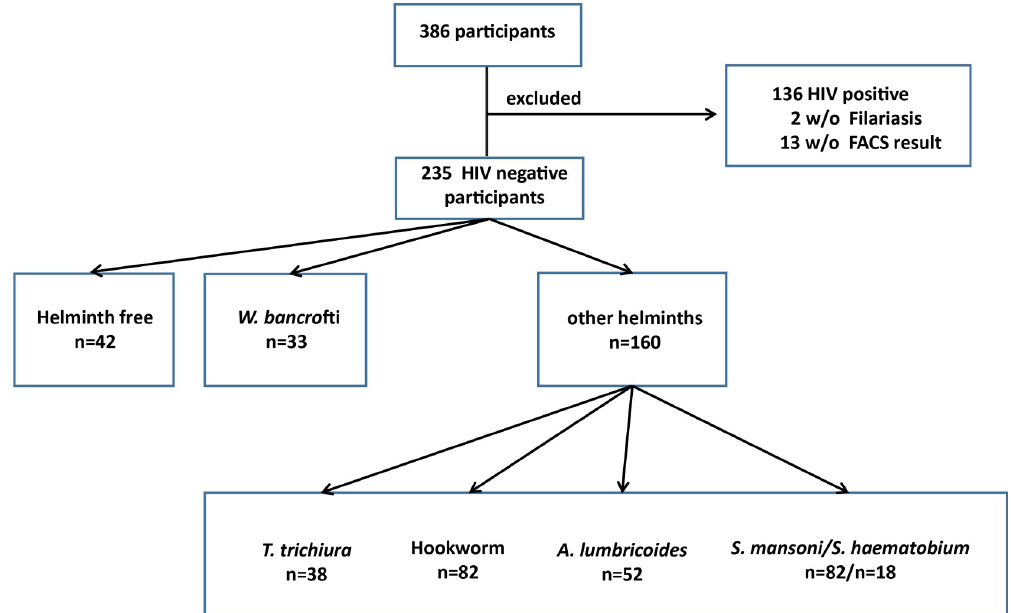
Fig 1. Participants and their grouping according to HIV and helminth infection status. For the analysis only HIV negative individuals with valid data for flow cytometry and W . bancrofti were included. The participants were separated into three different sub